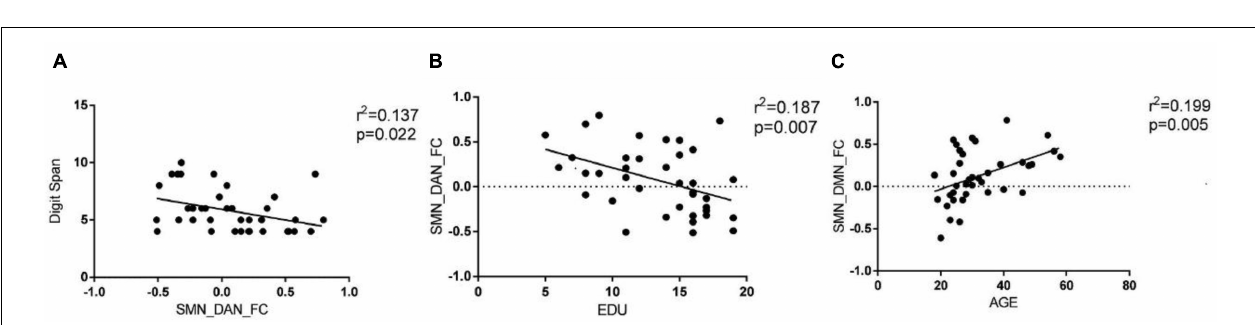
FIGURE 3 | (A) Internetwork functional connectivity in BD-I and HCs. (B) Comparison of functional connectivity between SMN and DAN in the two groups. (C) Comparison of functional connectivity between SMN and DMN in the two groups. * p < 0.05; ** p < 0.01.